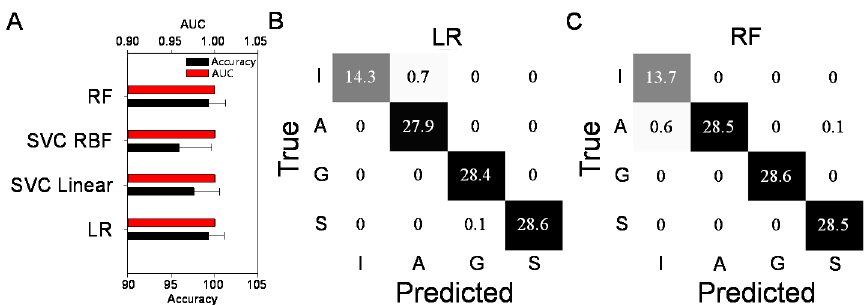
Figure 5. ML modeling prediction performances with the four ML models ( A ) and confusion matrices for the LR ( B ) and RF ( C ) models. The error bars indicate one standard deviation from the mean. The colors in the matrix denote the percentages (presented out of 100).